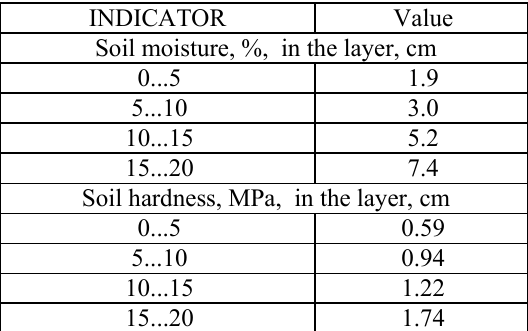
Figure 8. Static determination of the reaction acting on the balancing wheel using the VA-15 scales (a - remote control panel of the scales; b - scales platform)